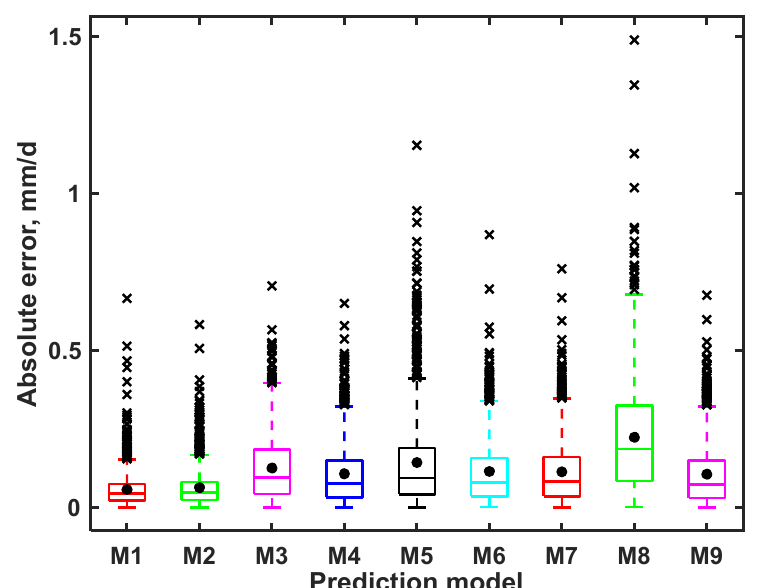
Figure 3. Absolute error boxplots. M1–M9 represent LSTM, Bi-LSTM, ANFIS, GPR, M5 tree, MARS_C, MARS_L, PLR, and SVR models, respectively.